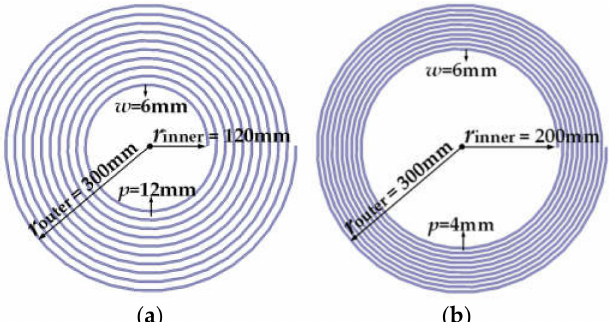
Figure 15. Channel width and inner radius changing: ( a ) 120 mm inner radius; ( b ) 200 mm inner